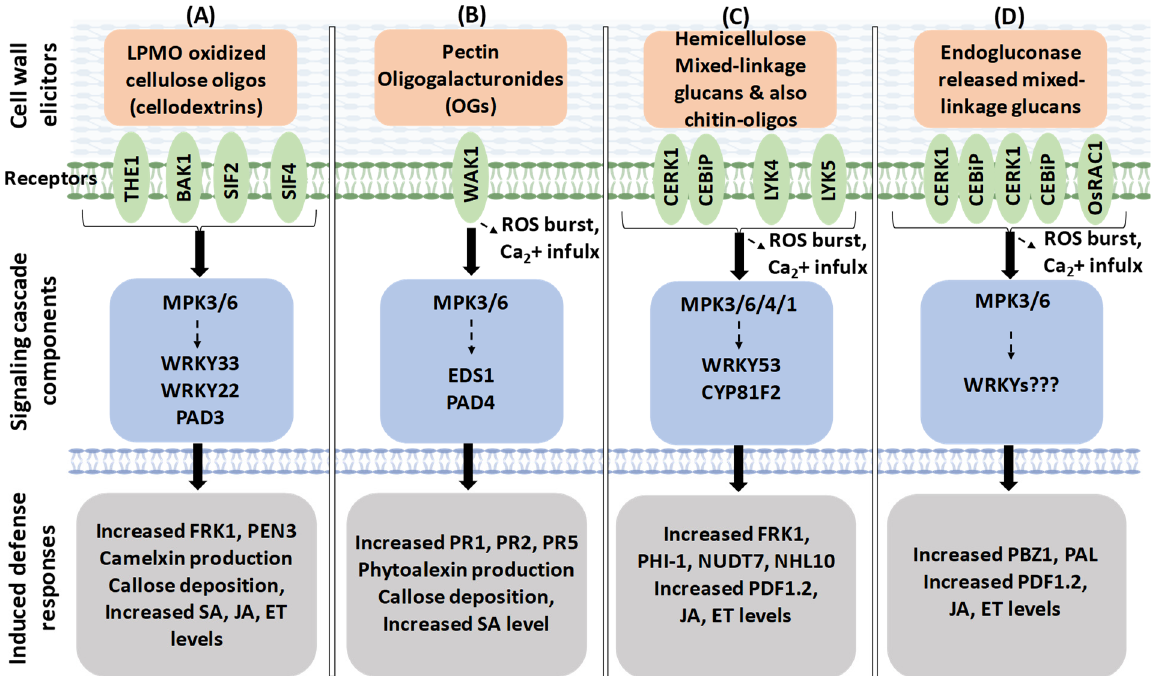
Figure 3. Defense pathways involved against the CWI alterations triggered by CWMEs or CWDEs. ( A ) Plant LPMO-oxidized cellulose oligosaccharides activated a signaling pathway, which resulted in resistance to B. cinerea in Arabidopsis. ( B ) Released CW pectin OGs activated an immune pathway that resulted in Arabidopsis resistance to B. cinerea and P. syringae pv. tomato DC3000. ( C ) Mixed- linked glucans (MLGs) DAMPs from digested rice CW triggered PTI, and, as a result, the Arabidopsis plants became resistant to H. arabidopsidis . ( D ) CW-MLGs released from pathogen endoglucanases-overexpressor rice plants activated immune responses, resulting in enhanced resistance to M. oryzae .